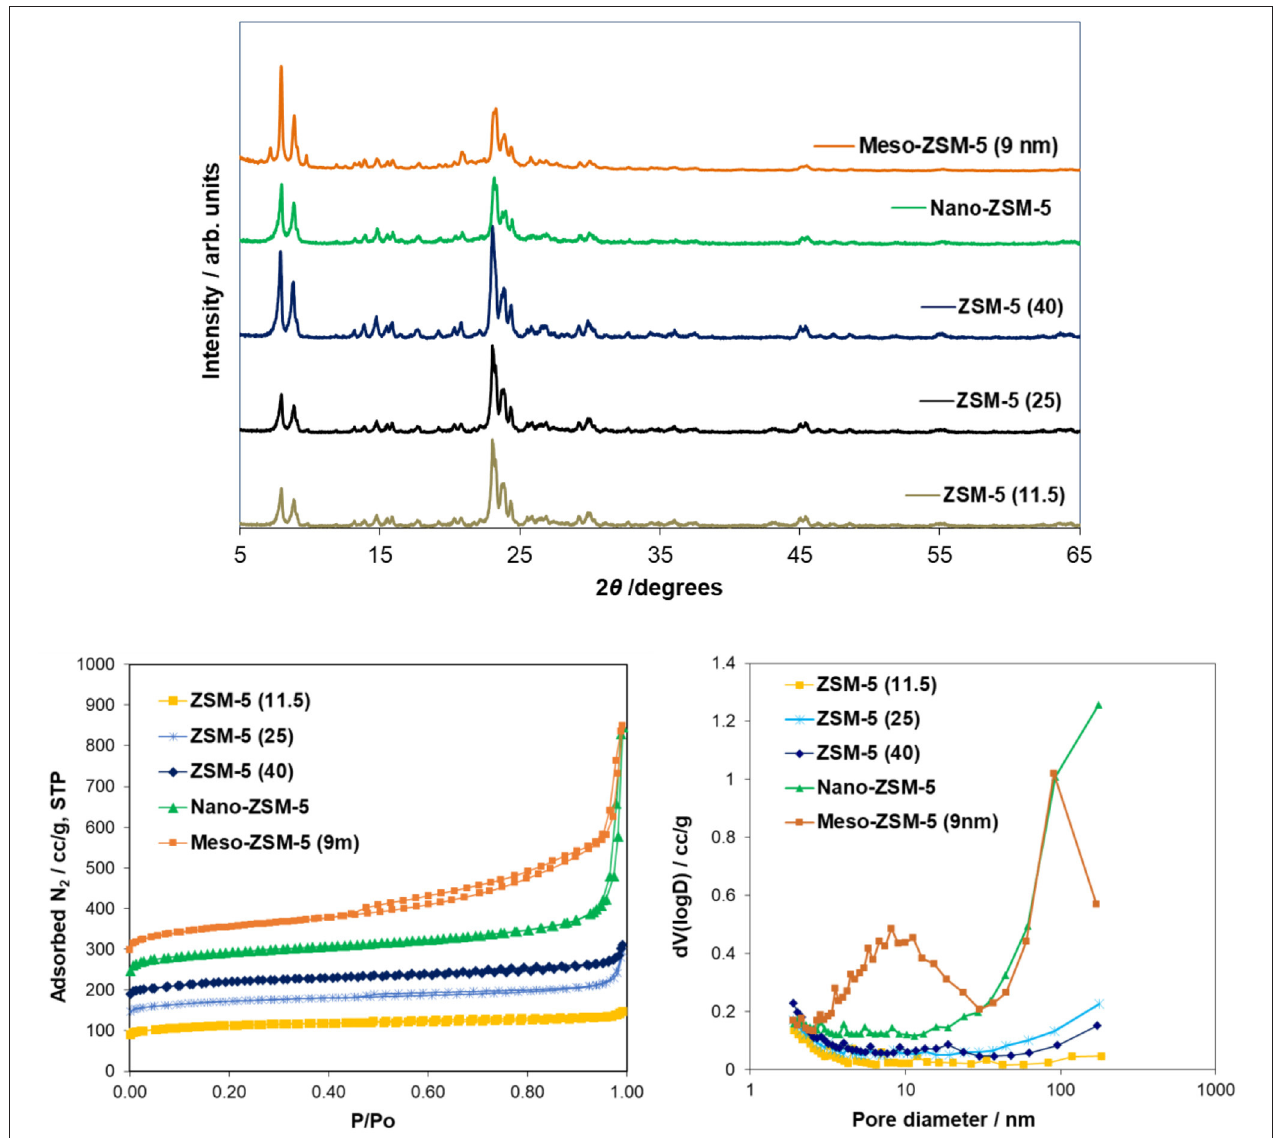
FIGURE 3 | X-ray diffraction patterns (XRD) and N 2 adsorption-desorption isotherms of the conventional microporous ZSM-5 (Si/Al = 11.5, 25, 40) zeolites, the nanosized ZSM-5 zeolite synthesized under controlled/mild template hydrothermal synthesis, and the mesoporous ZSM-5 (9nm) zeolite prepared by mild alkaline treatment of the conventional ZSM-5(40)